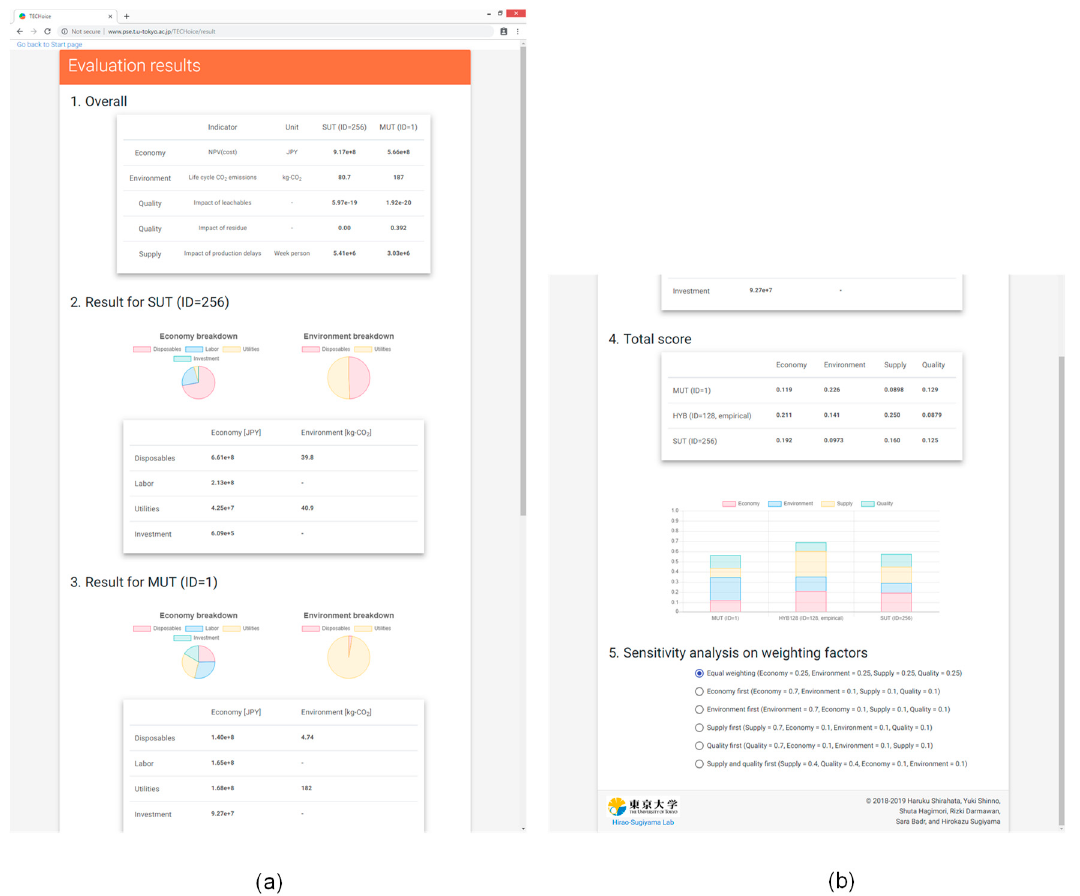
Figure A4. ( a , b ) Screenshot of the fourth page (Evaluation results) of “ TECH oice”.